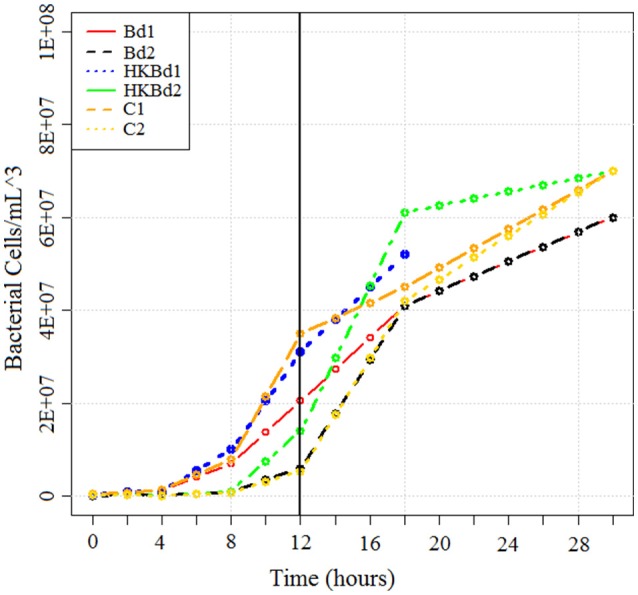
Growth curve of bacteria in all treatments obtained using serial dilution plating. RNA was extracted at T = 12 h (indicated by vertical line). Bd1 and Bd2 indicate S. marcescens strains one and two grown with Bd, respectively. Heat-killed Bd1 and heat-killed Bd2 indicates S. marcescens strains one and two grown with heat killed Bd, respectively. No Bd1 and no Bd2 indicates S. marcescens strains one and two grown without any Bd, respectively.